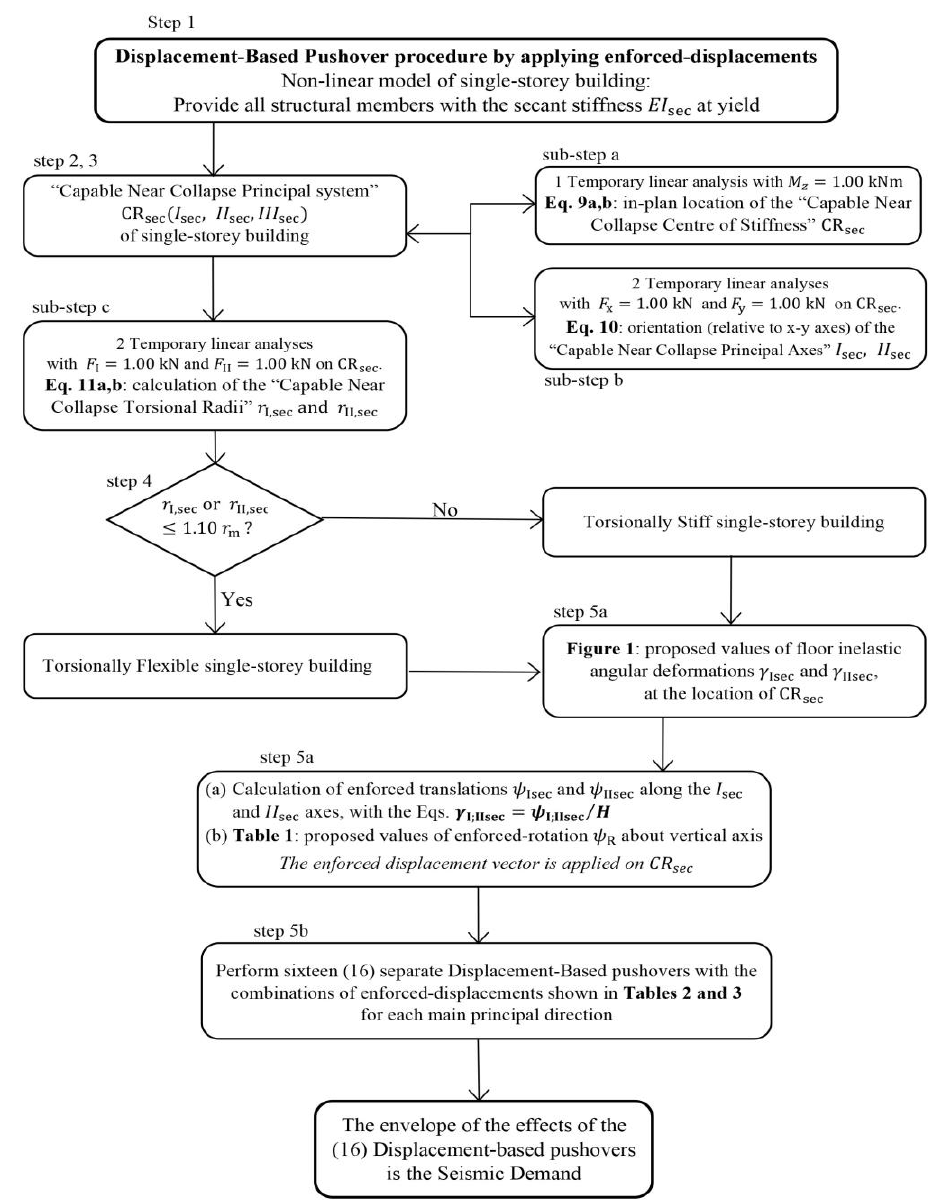
Fig. 3 . Flowchart of the application steps of the proposed Displacement-Based pushover